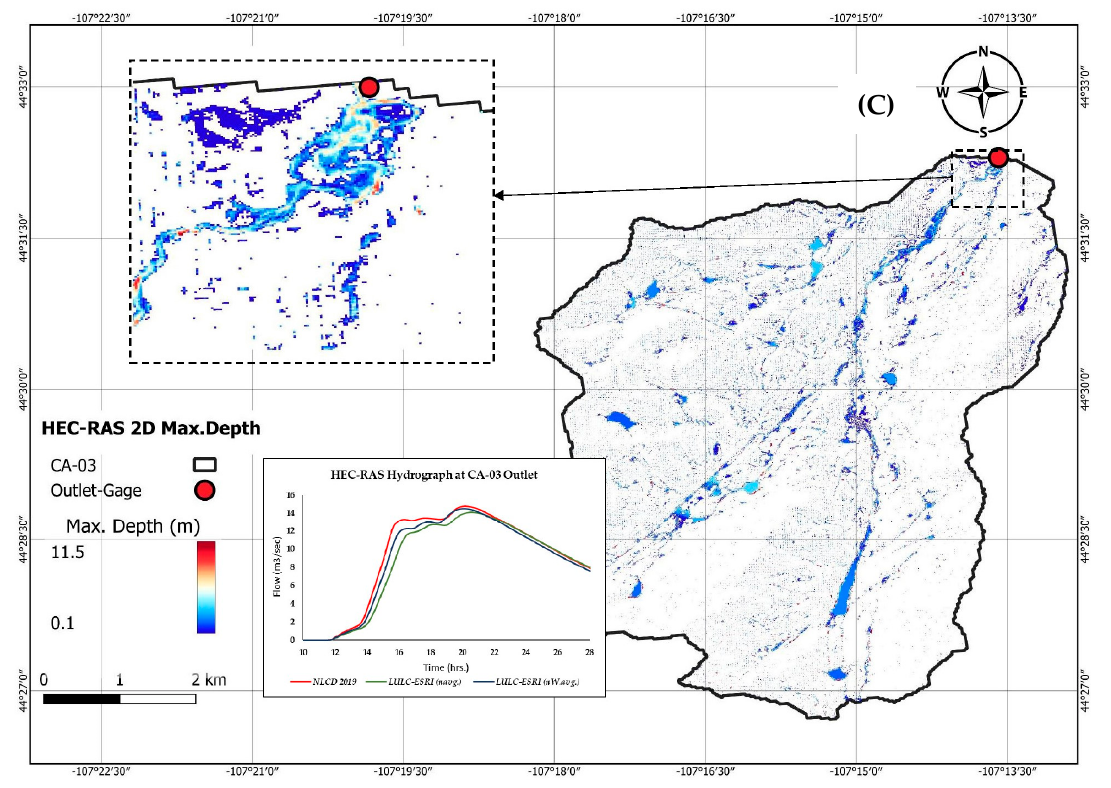
Figure A10 . HEC-RAS 2D calibration results, maximum depth, hydrograph at outlet ( A ) Catchment CA-01, ( B ) Catchment CA-02, ( C ) Catchment CA-03.